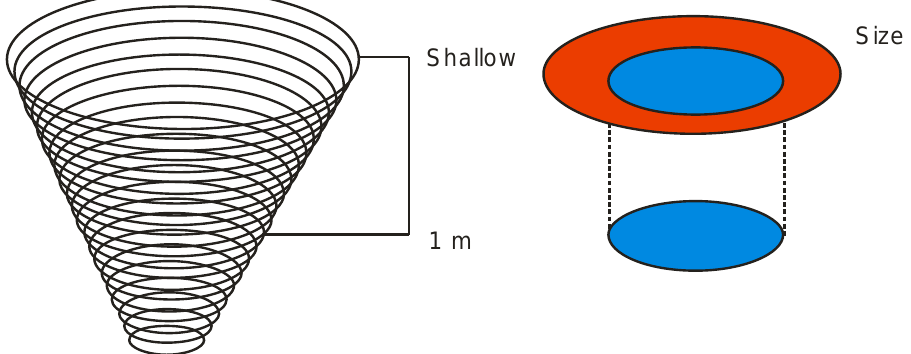
Figure 4. Hypothetical dolines enlargement from threshold depths equal to 1 m and “shallow” ( i.e. , > 0 m).